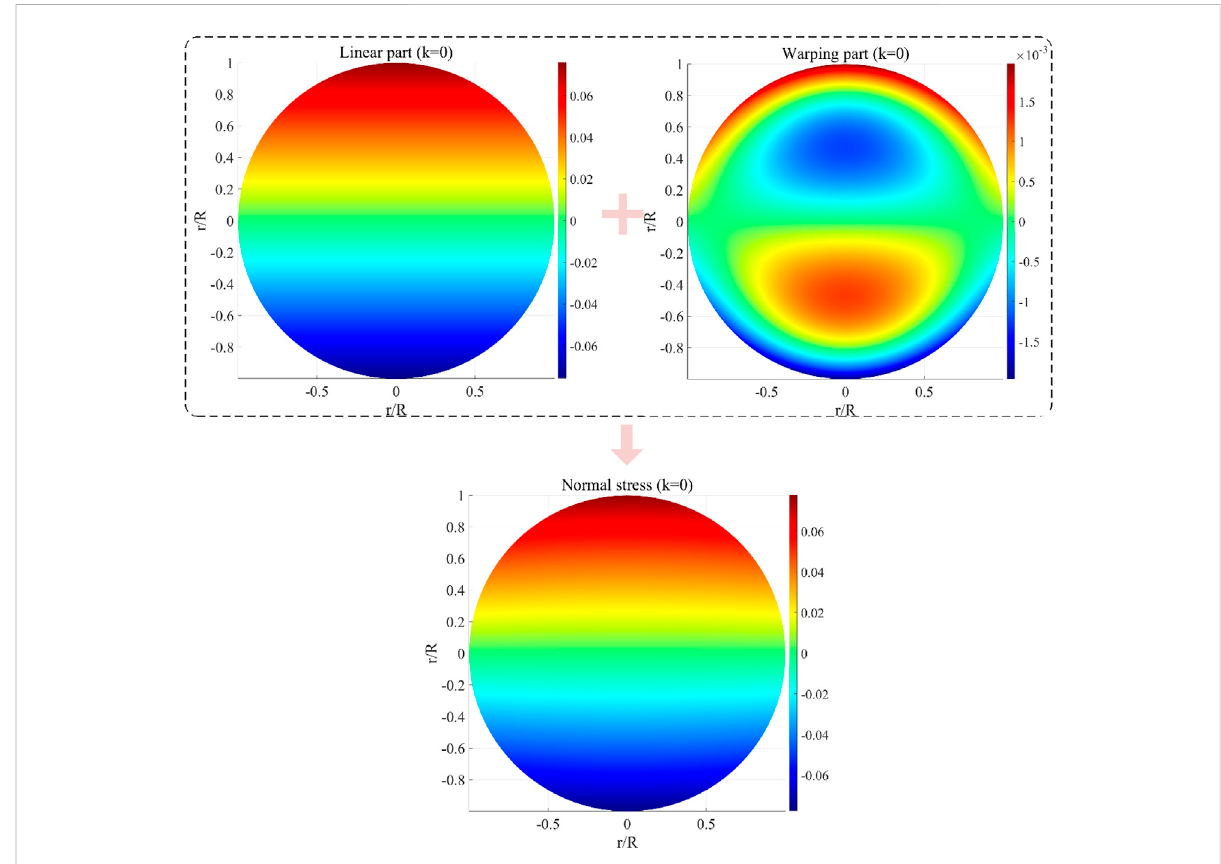
FIGURE 6 The normal stress and its decomposition for k =